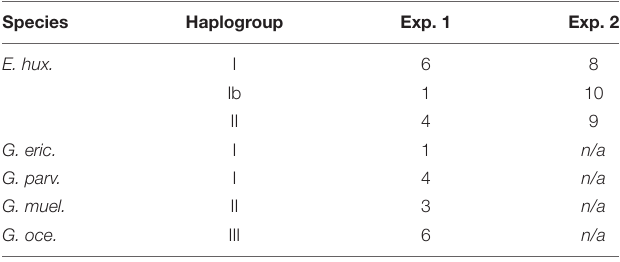
Strains used and thermal reaction norms calculated are listed in Supplementary File 4